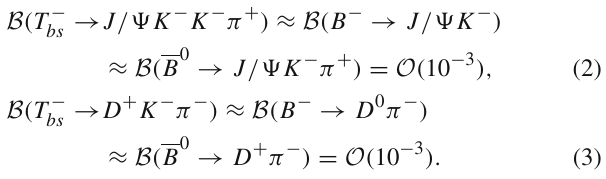
the collisions. The dominant topological decaying diagrams − → J /(cid:7) K − K − π + are shown in Fig. 3. The decay of T bs is dominated by the color-suppressed emitted tree diagram, − → D + K − π − by the color-favored emitted tree while T bs diagram. Both of them contribute to relatively large branch- ing fractions [56]. The branching fractions are approximately similar to those of corresponding B meson decays at the lead- ing order of the heavy quark